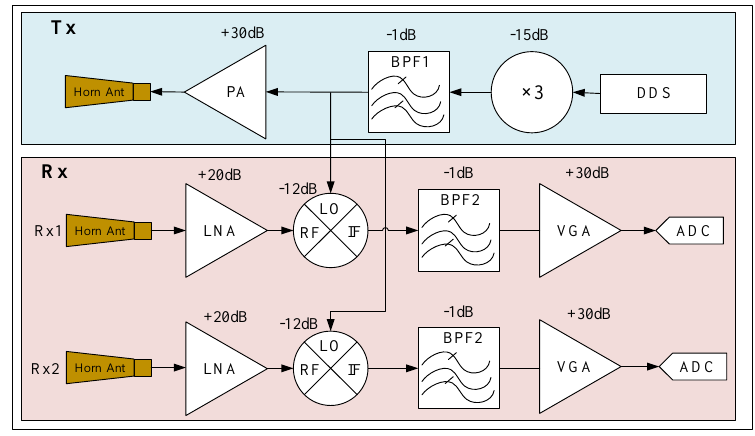
Figure 5. Block diagram of the S-Band FMCW TWRI radar system.